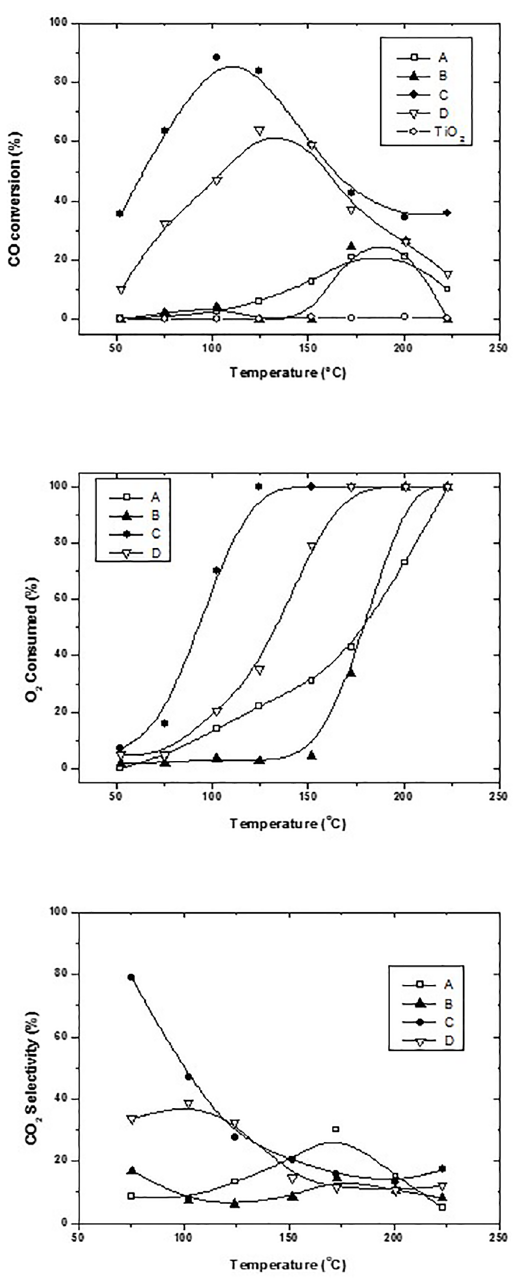
consumed and CO selectivity in 2 2 catalysts. 2 2